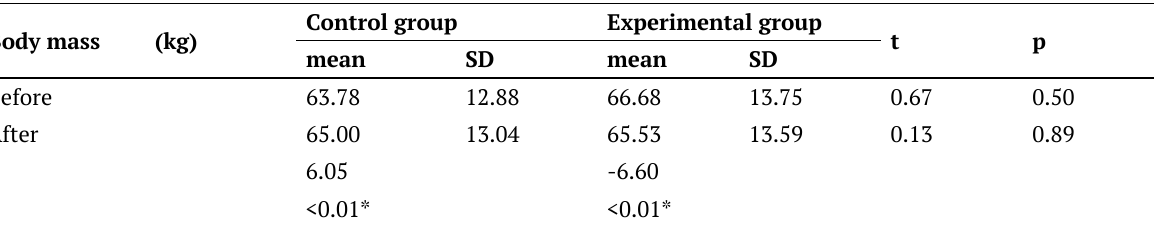
Table 5. The comparison of body mass between experimental group and control group before and after experiment